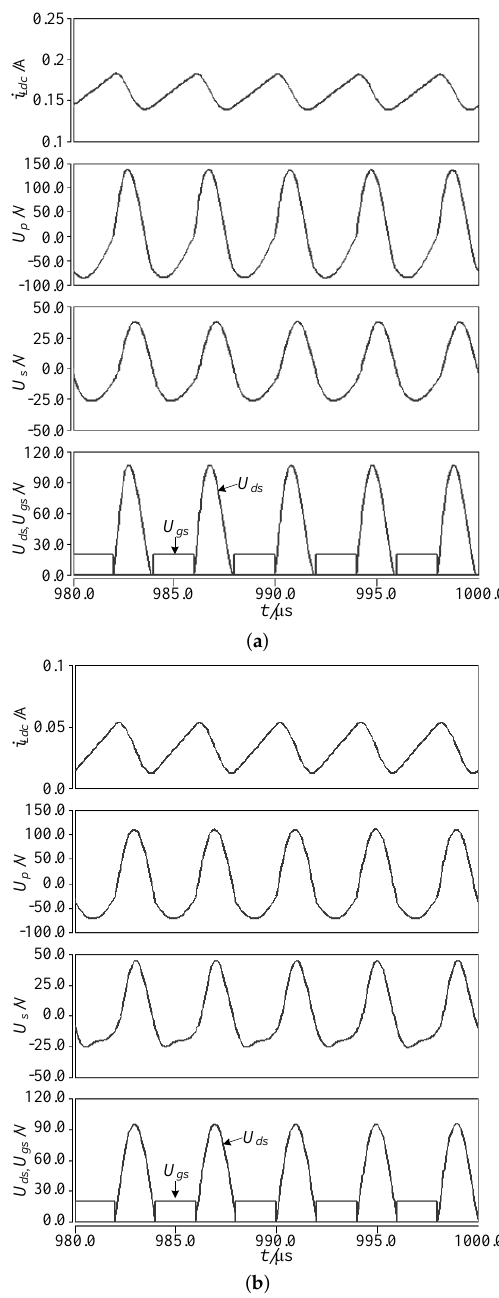
Figure 8. Simulation waveforms under different loads: ( a ) R L = 100 Ω ; ( b ) R L = 600 Ω